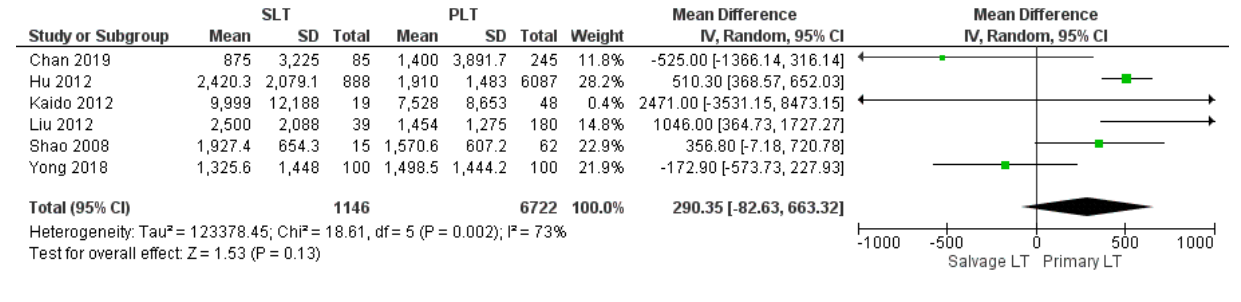
Figure 3. Intraoperative blood loss.